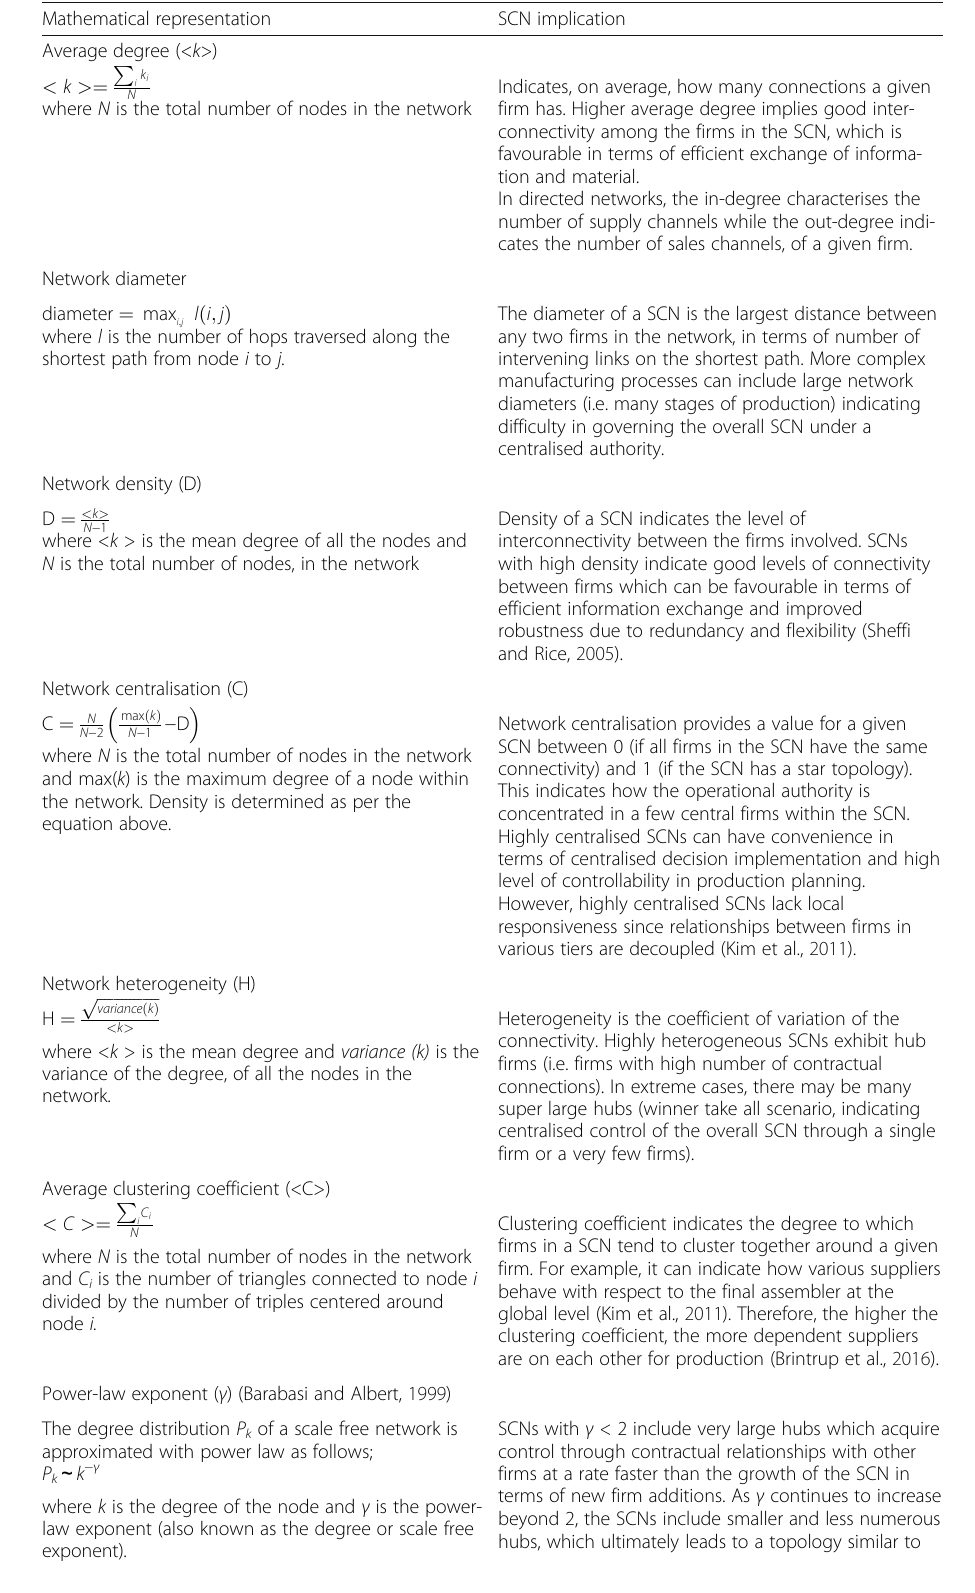
Table 4 Network level metrics and their SCN